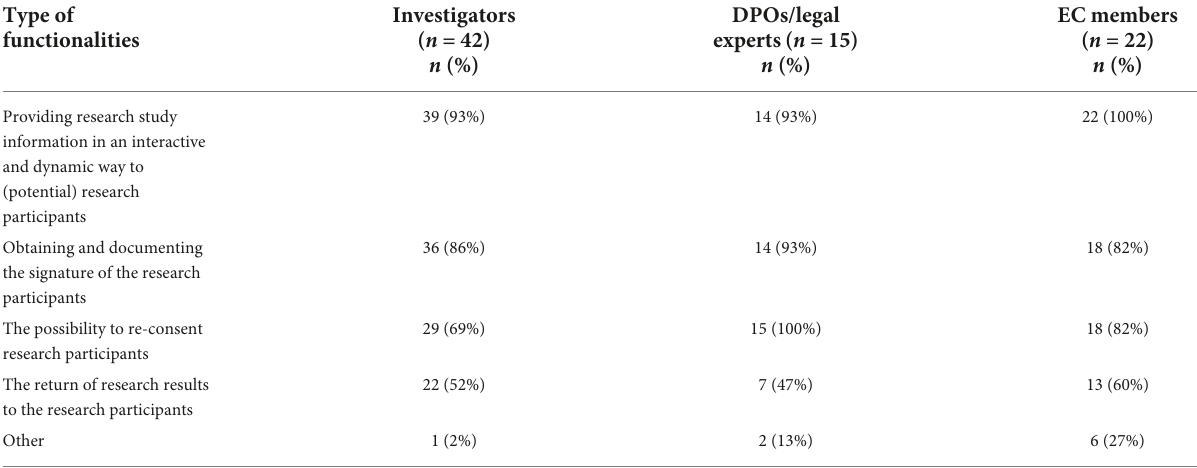
TABLE 4 Type of functionalities of an eIC system. Type of